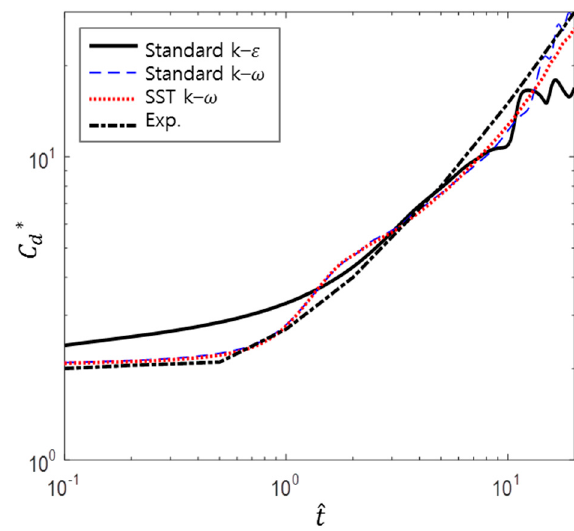
Figure 6. Comparison of di ff erent turbulence models (experimental data from Sarpkaya and Garrison [16])